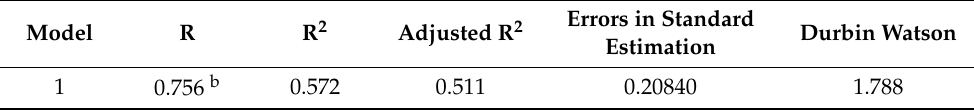
Table 7. Model Summary a .